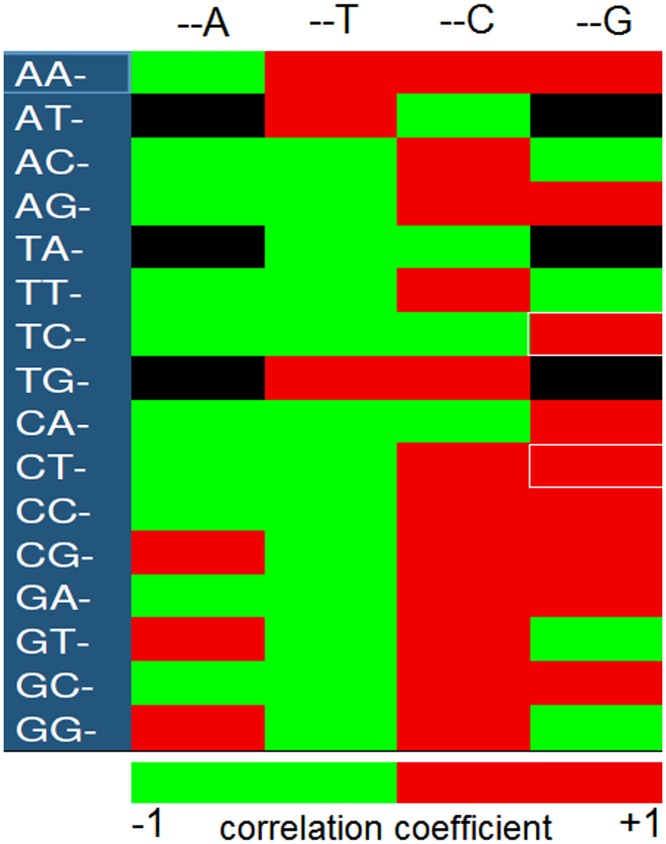
Heat maps of correlation coefficient of codons with GC3.The color coding red represents the positive correlation, green as negative correlation. The black fields are stop codons (TAA, TAG, TGA) and non-degenerate codons (ATG, TGG) together with ATA codons for isoleucine which was altogether absent in TP53 gene across mammalian species. White marked rectangular boxes are the codons that showed strong positive correlation with GC3s.